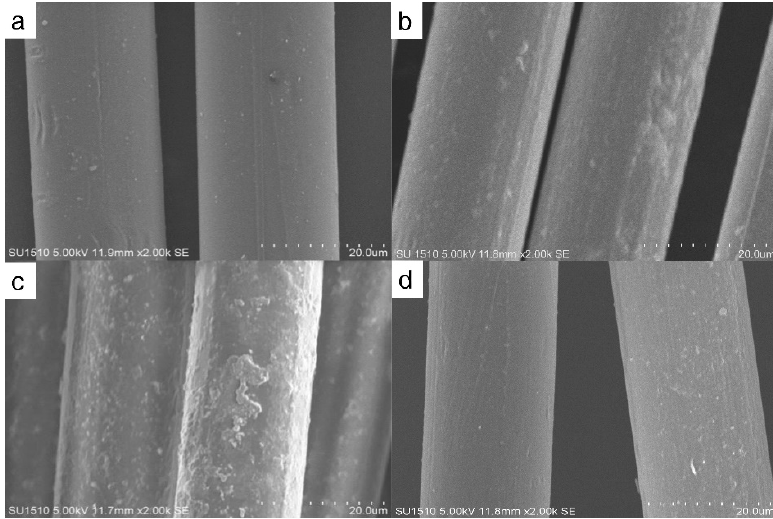
Figure 1. SEM images of polyester fibers: ( a ) before any treatment; ( b ) after cleaning with NaOH and lauryl sodium sulfate (LSS); ( c ) after coarsening with NaOH; and ( d ) after sensitizing with SnCl 2 .